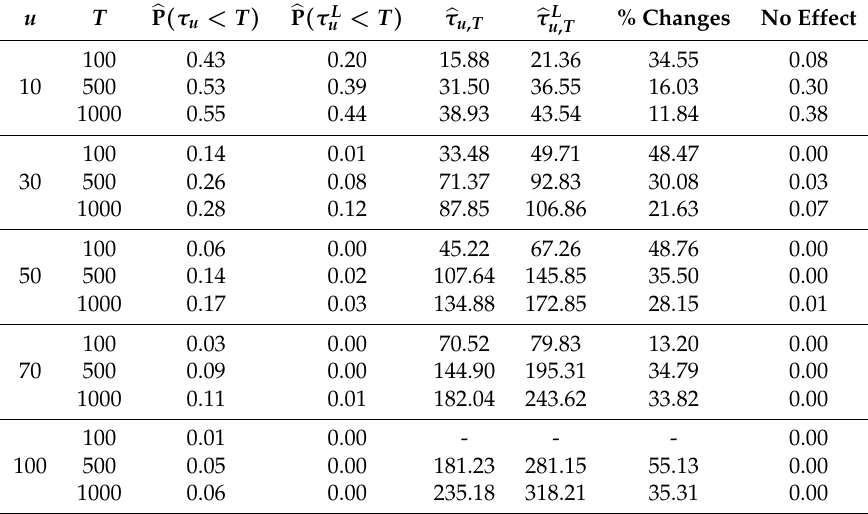
Table 4. EOL reinsurance for Pareto ( 2,1 ) distributed claims. The safety loading is θ = 0.1, expected claim size is µ = 2, claim arrival rate is λ = 1, and each time unit is 0.01 years. Simulations are done with N = 100,000 sample paths. Retention level L is the solution to (17). For T =